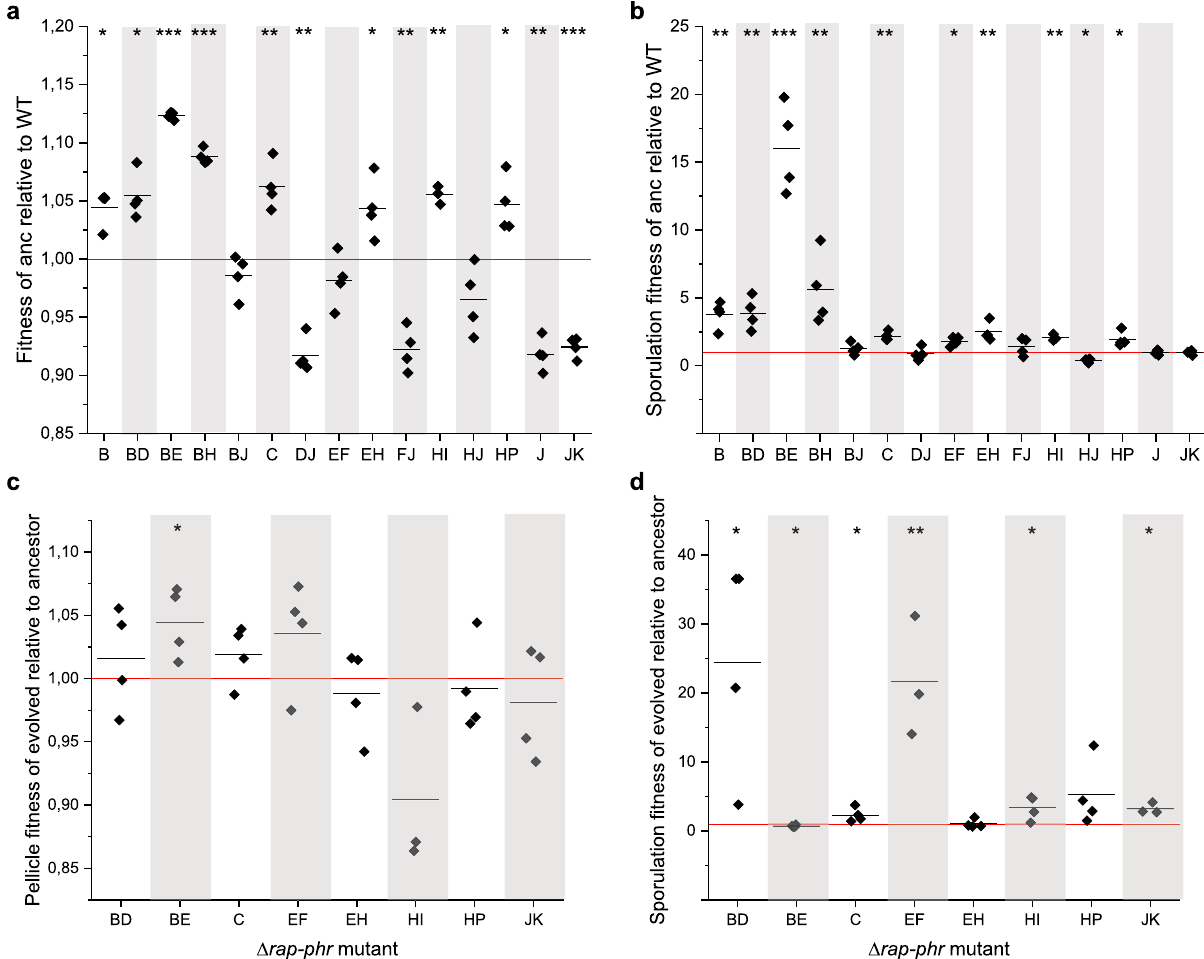
Fig. 6 The impact of rap – phr deletions and additional mutations arisen during the experiment on fi tness and sporulation. To test the impact of the rap – phr deletions on fi tness and sporulation, mutants showing persistence in several replicates after transfer 9 (>1.27% abundance) were competed against the WT in MSgg medium to allow pellicle development. Similarly, to test the effect of the extra mutations arisen during the experiment on fi tness and sporulation, the isolated evolved strains were competed against their cognate ancestor in MSgg medium. After 2 days, the developed pellicles were harvested, sonicated, and exposed to heat treatment in order to kill vegetative cells. Total cell suspensions as well as heat-treated cell suspensions were plated to quantify total cell number and number of spores. a Relative fi tness of the ancestor rap – phr mutant strain compared to WT. b Sporulation fi tness of the ancestor rap – phr mutant strain compared to WT. c Relative fi tness of evolved rap – phr mutant strain compared with its cognate ancestor. d Sporulation fi tness of the evolved strains compared to its cognate ancestor. Data are represented with technical replicates ( n = 4) as squares and the mean of the replicates are indicated as a black line ( n = 3 – 4). The red horizontal line denotes the WT ( a , b ) or the cognate rap – phr mutant ancestor ( c , d ). For statistical analysis, the relative (sporulation) fi tness was log-transformed and a one-sample t -test was performed to test whether the mean was signi fi cantly different from 0. * P < 0.05, ** P < 0.005, *** P <